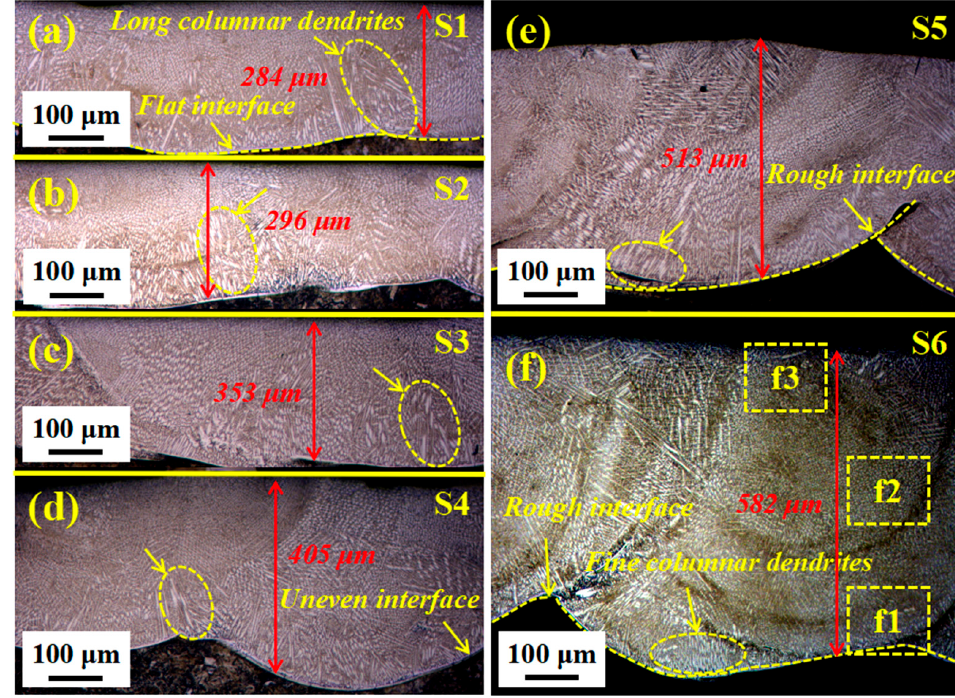
Figure 2. Typical OM diagram of a cross-section of composite coating with different ceramic micro-particle content. ( a ) S1; ( b ) S2; ( c ) S3; ( d ) S4; ( e ) S5; ( f ) S6.